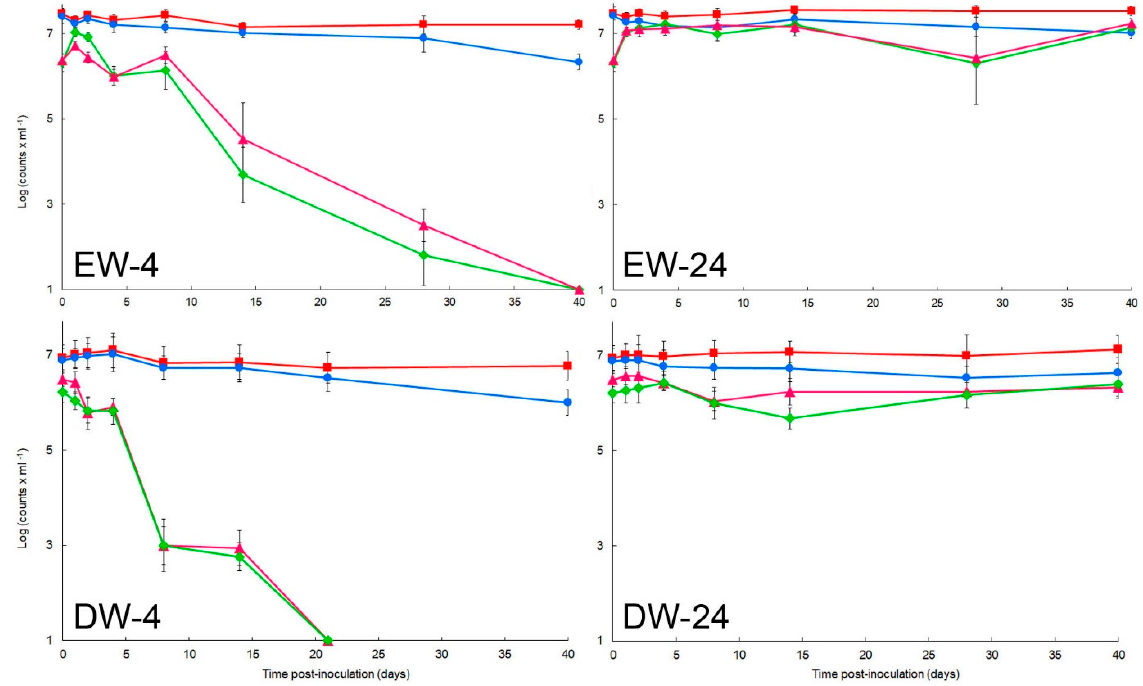
Figure 1. Effect of low temperature under nutrient-limiting conditions on survival of Ralstonia solanacearum strain IVIA-1602.1 during 40-day periods in water. Microcosms of: EW − 4, environ- mental water at 4 ◦ C; DW − 4, distilled water at 4 ◦ C; EW − 24, environmental water at 24 ◦ C, and DW − 24, distilled water at 24 ◦ C. Total ( (cid:4) ), viable ( • ), and culturable cells on SMSA ( (cid:78) ) and YPGA ( (cid:7) ) media. Data from one representative environmental water sample have been plotted. Points are mean ± standard deviation of triplicate